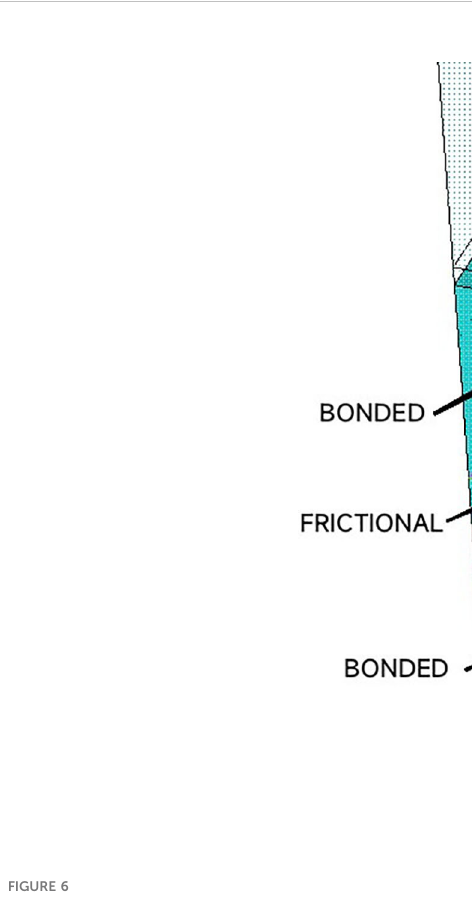
FIGURE 6 Contact surfaces in a local fl